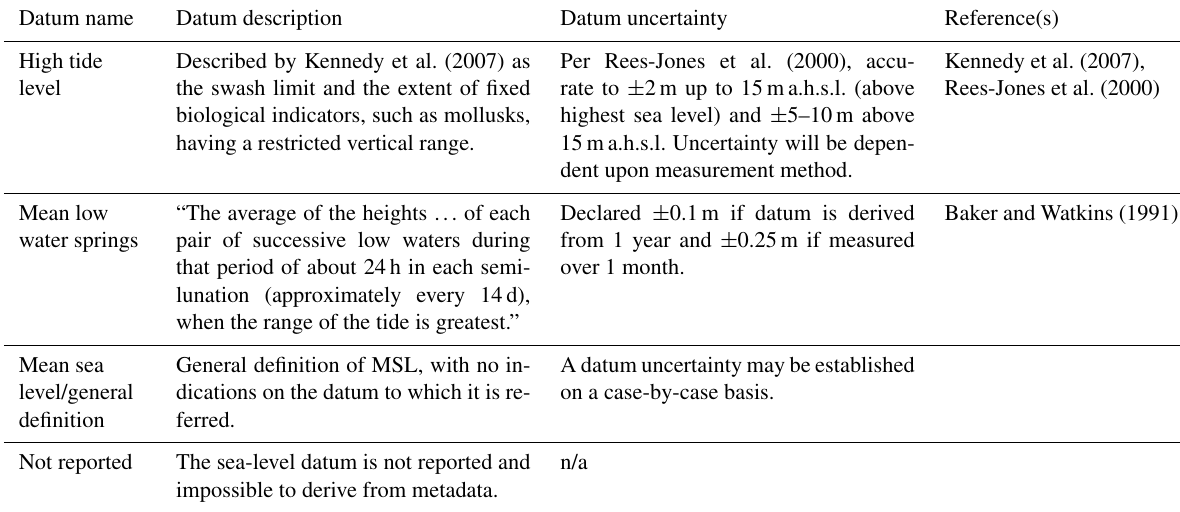
Table 3. Sea-level datums reviewed in this study, modified and exported from Boyden et al.